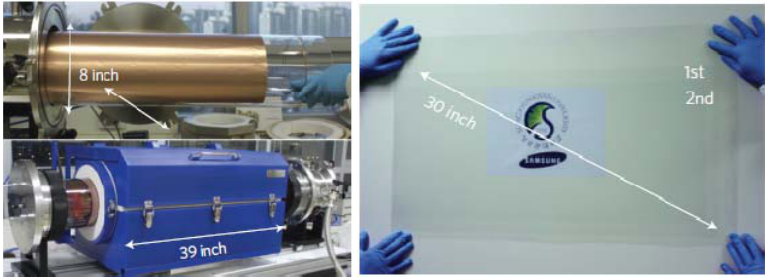
Figure 9. Image of a copper foil wrapped around a quartz tube to be placed in a furnace for chemical vapor deposition is shown on the left; A large area transparent graphene film transferred on a transparent substrate is shown on the right. Reprinted with permission from [23]. Copyright (2010) by the Macmillan Publishers